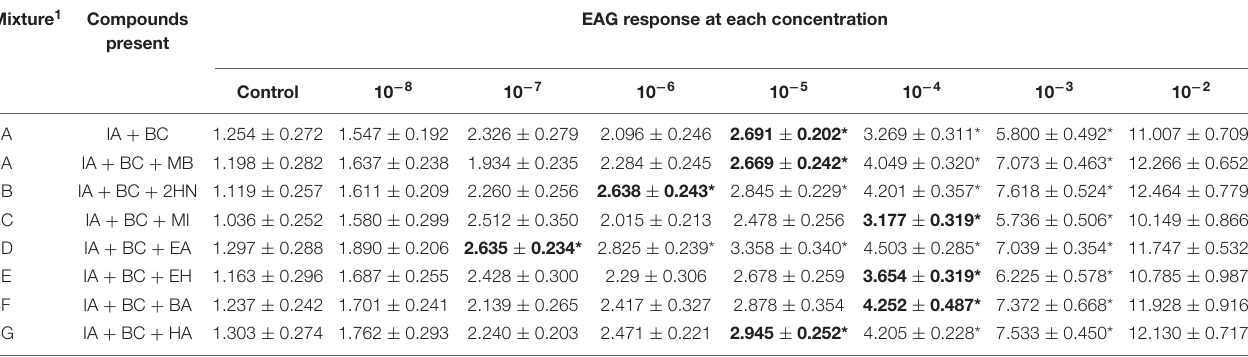
EAG response at each concentration